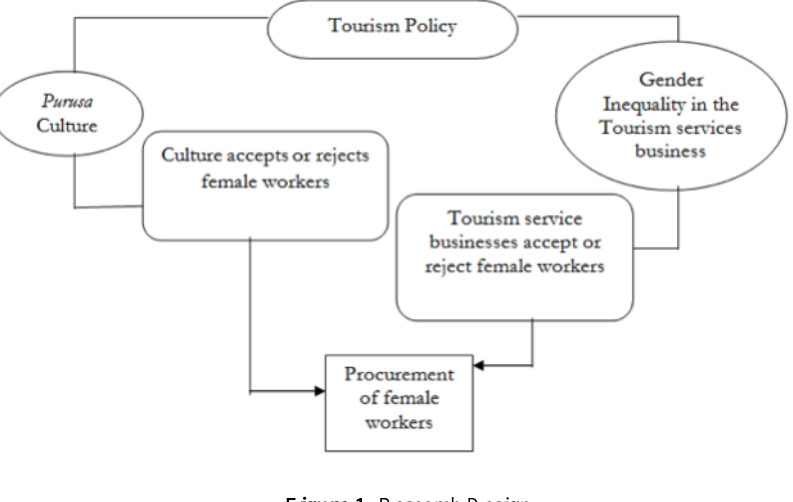
Figure 1: Research